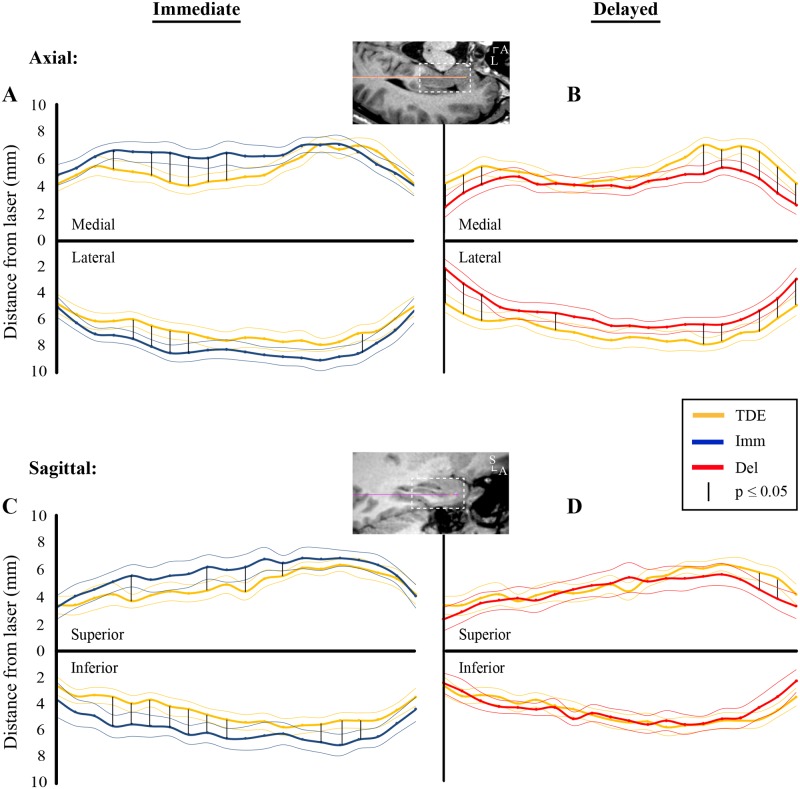
Comparison of averaged TDE maps and ablation zone boundaries for entire patient cohort.(A) Composite maps showing averaged axial TDEs (yellow) and immediate ablation boundaries through the same imaging plane (blue) for all patients in the study (N = 28). Thick lines show mean distance from the laser and thin lines mean ± standard error. Vertical black lines show positions along the laser where TDE maps differed from the ablation zones with p ≤ 0.05, determined using bootstrap analysis. (B) Axial TDE maps (yellow) and delayed ablation boundaries (red). The axial MRI above estimates the mesiotemporal location of data used for A and B. (C) Sagittal TDE maps (yellow) and immediate ablation boundaries (blue) (N = 16). (D) Sagittal TDE maps (yellow) and delayed ablation boundaries (red). The sagittal MRI above estimates the mesiotemporal location of data used for C and D. A, anterior; Del, delayed; Imm, immediate; L, lateral; S, superior; TDE, thermal damage estimate.